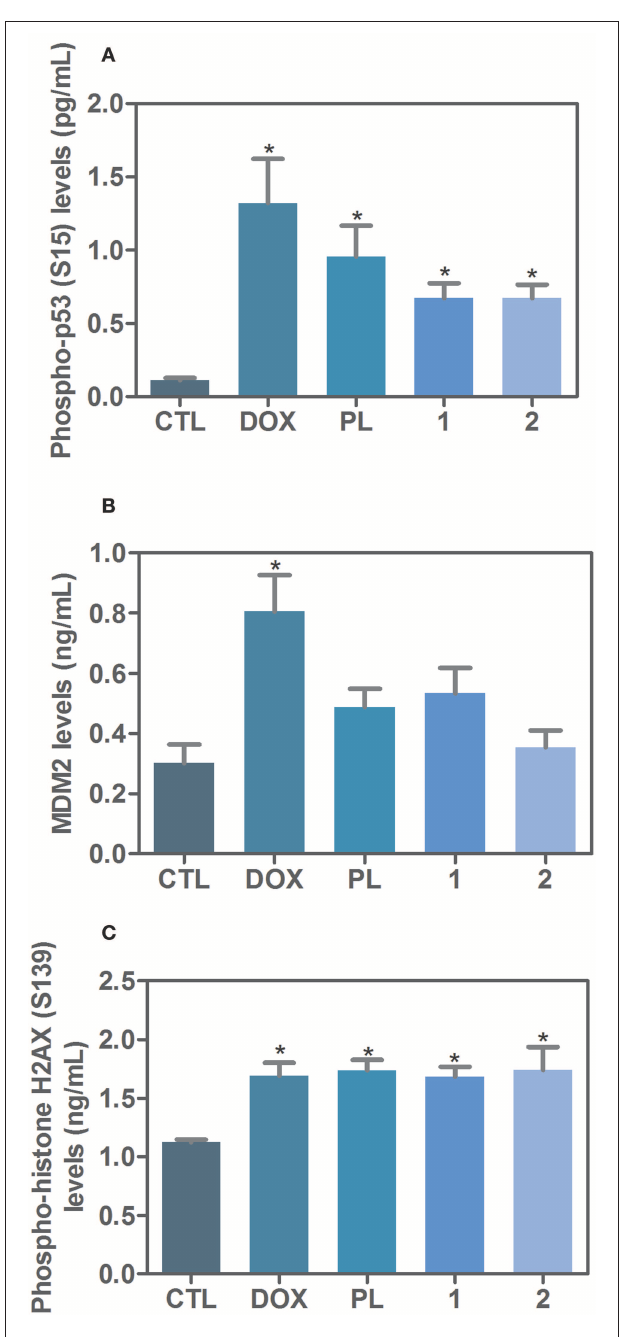
FIGURE 5 | Effect of ruthenium complexes with piplartine in phospho-p53 (S15), MDM2 and phospho-histone H2AX (S139) levels, as determined by phospho-specific ELISA in HCT116 cells treated with ruthenium complexes at established concentration (2.5 µ M for complex 1 and 5 µ M for complex 2 ) for 24h incubation. (A) Quantification of phospho-p53 (S15) levels. (B) Quantification of MDM2 levels. (C) Quantification of phospho-histone H2AX (S139) levels. Negative control was treated with the vehicle (0.1% of a solution containing 70% sorbitol, 25% tween 80 and 5% water) used for diluting the complexes tested. Doxorubicin (1 µ M) and piplartine (10 µ M) were used as positive controls. Data are presented as mean ± S.E.M. of three independent experiments performed in duplicate. * P < 0.05 compared with negative control by ANOVA, followed by Student-Newman-Keuls